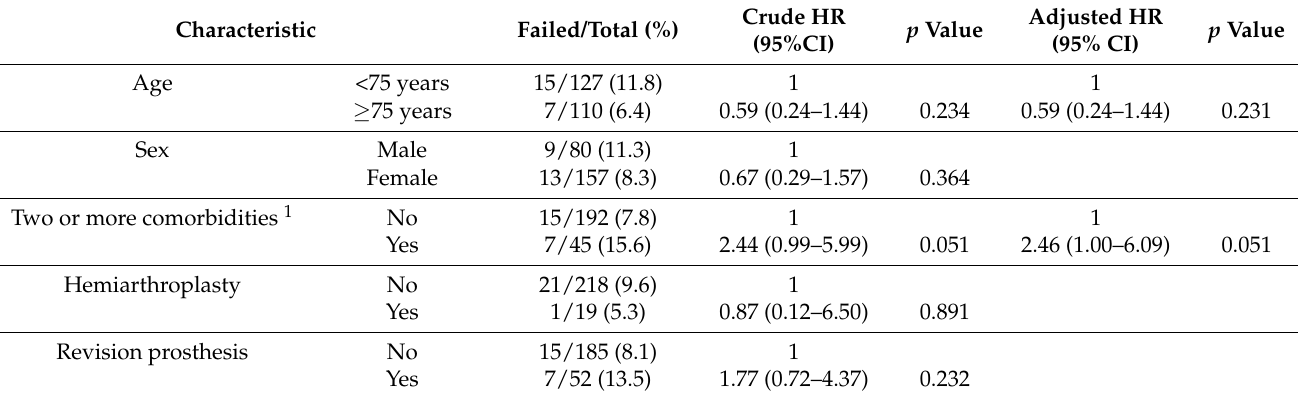
Table 3. Predictive factors of local failure among 237 cases of prosthetic joint infection by Staphylococcus aureus managed with implant removal (22 cases